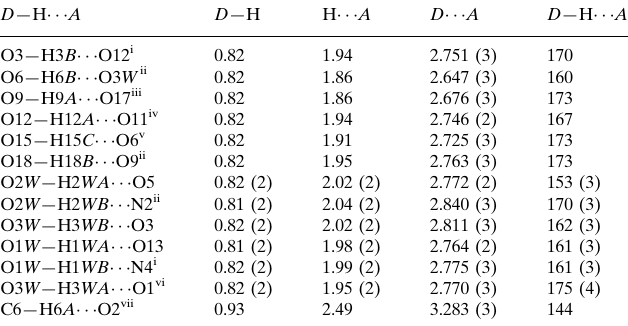
Hydrogen-bond geometry (A˚ , (cid:3) ). D —H (cid:2)(cid:2)(cid:2)